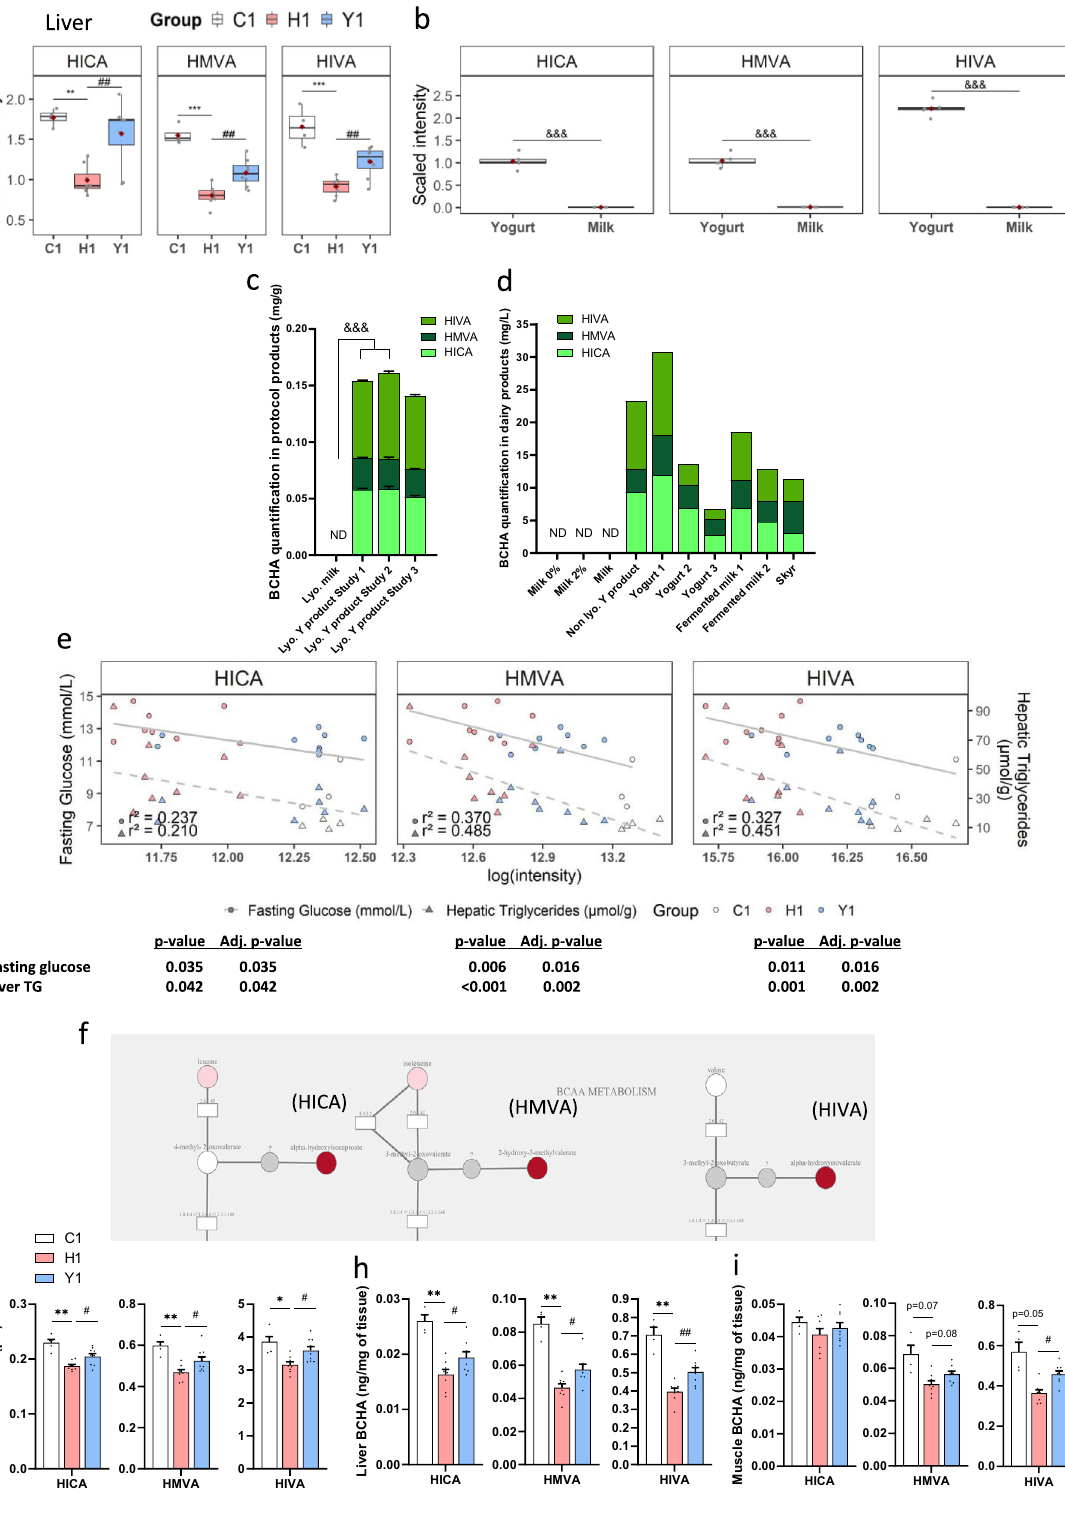
metabolome data and further demonstrate that diet-induced obesity causes a dysregulation of BCAA metabolism that circulation and in metabolic tissues, and that this defect can be partly prevented by yogurt